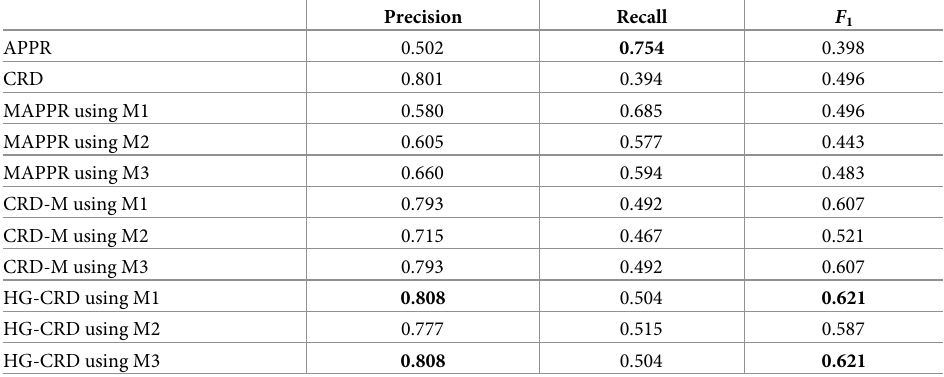
The numbers for APPR and MAPRR are taken from [16].